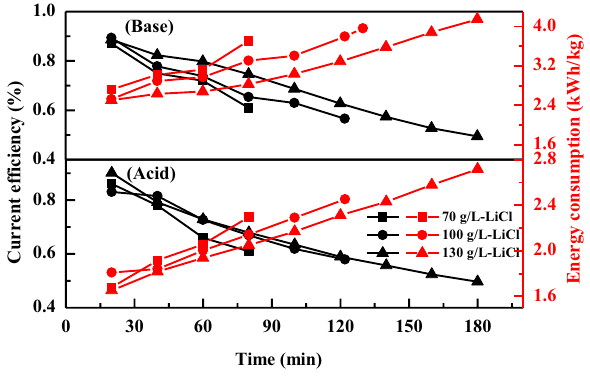
Fig. 6 Efficiency and energy consumption curves of HCl and LiOH